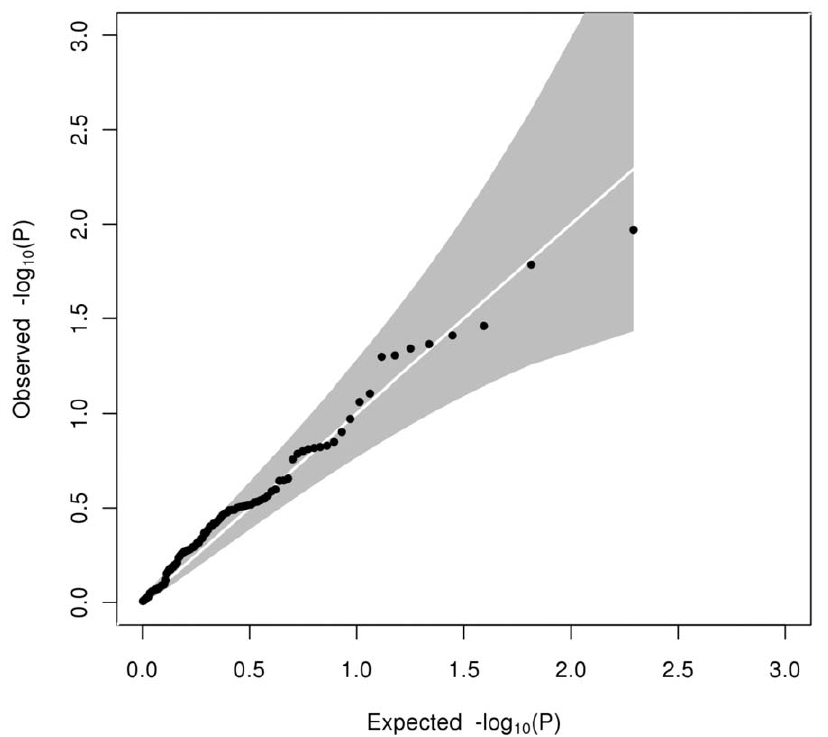
Figure 3. Quantile-quantile plot of observed against expected heterogeneity P-value for allelic associations with triglycerides. The grey shaded area represents the 95% confidence interval. Figure S1 Quantile-quantile plot of observed against expected heterogeneity P-value for allelic associations with HDL-C for all SNP with 95% confidence interval (grey shaded area). Figure S2 Quantile-quantile plot of observed against expected heterogeneity P-value for allelic associations with LDL-C for all SNP with 95% confidence interval (grey shaded area). Figure S3 Quantile-quantile plot of observed against expected heterogeneity P-value for allelic associations with triglycerides for all SNP with 95% confidence interval (grey shaded area). Figure S4 Alleleic effects and Error bars SE for each estimated effect of minoar allele by age group at (A) rs247616 ( CETP ) on HDL-C; (B) rs445925 ( APOE ) on LDL-C; (C) rs8073909 ( AKAP1/ MSI2 ) on LDL-C; (D) rs11258628 ( FRMD4A ) on LDL-C; (E) rs7890572 (IL1RAPL1) on triglycerides; (F) rs12280753 ( CADM1 )